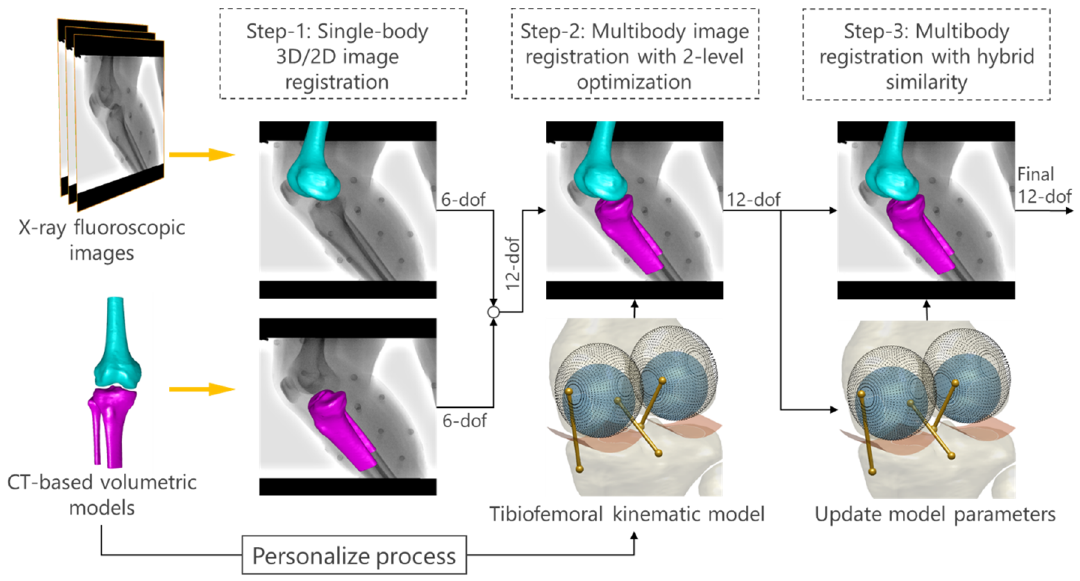
Figure 3. The overall scheme of the proposed multibody model-based tracking method. A three-step 3D/2D image registration was implemented to successively improve the reproduction of tibiofemoral 3D poses.